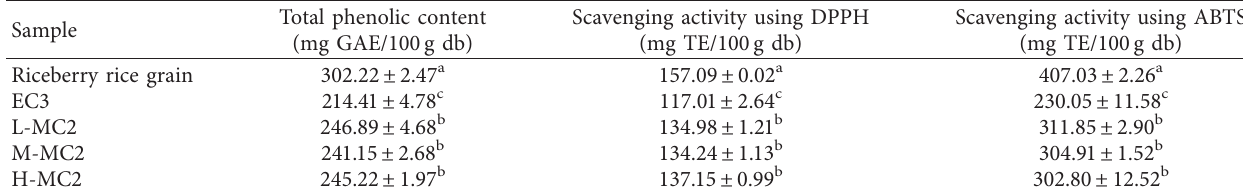
Table 3: Total phenolic content and antioxidant activity of the rice grain and the cooked rice from conventional cooking and microwave cooking.